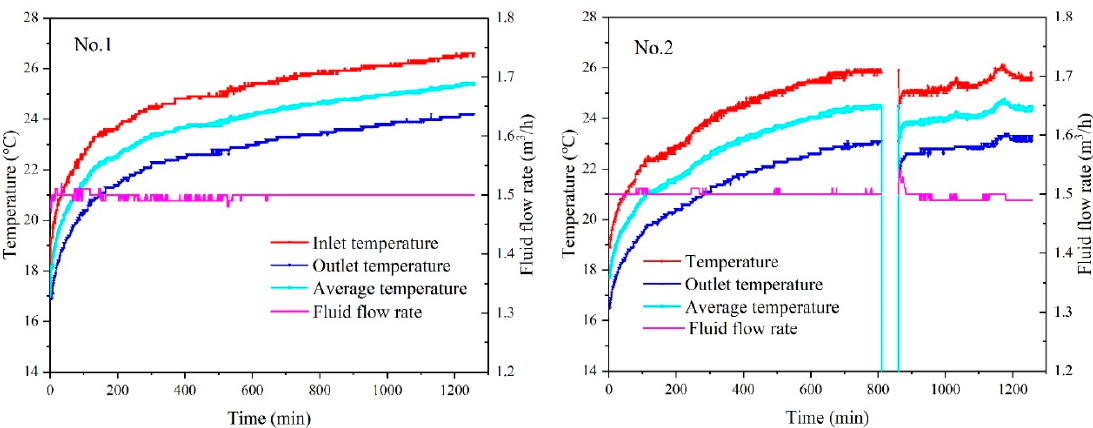
Figure 4. The records of thermal response test including inlet-outlet fluid temperature and fluid flow rate for two borehole exchangers. A significant drop at 800 min of the fluid flow and temperature indicates a power off event.